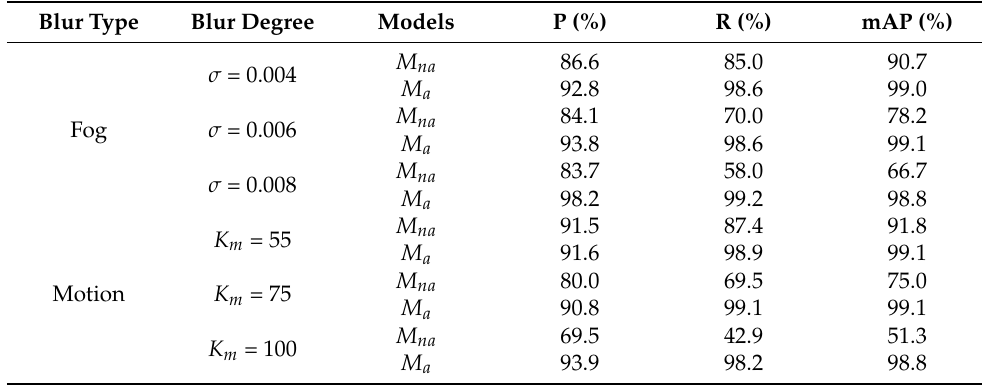
Table 3. Evaluation Results on Fog and Motion Blur